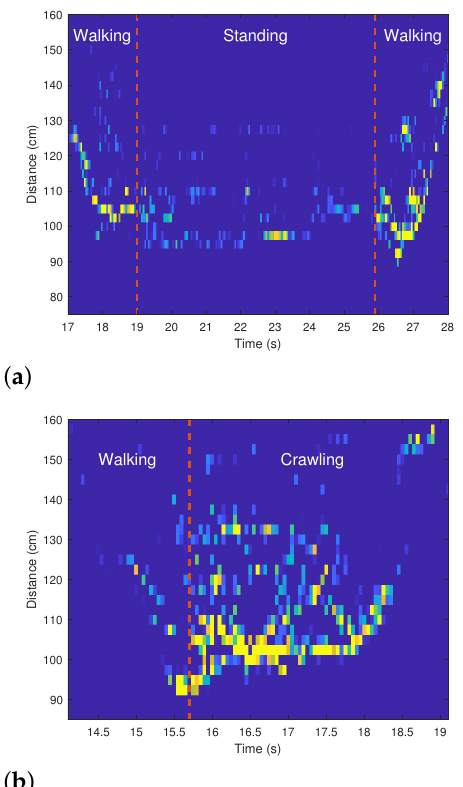
Figure 8. Spectrograms according to changes in human motion: ( a ) From walking to standing, and then walking again. ( b ) From walking to